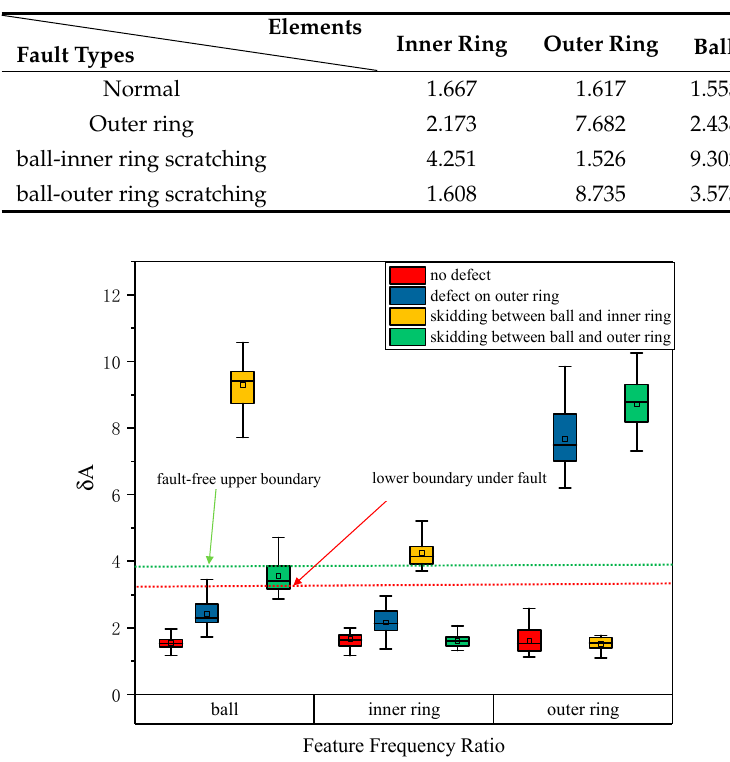
Figure 9. Box-plot diagram of the characteristic frequency ratio of various faults.